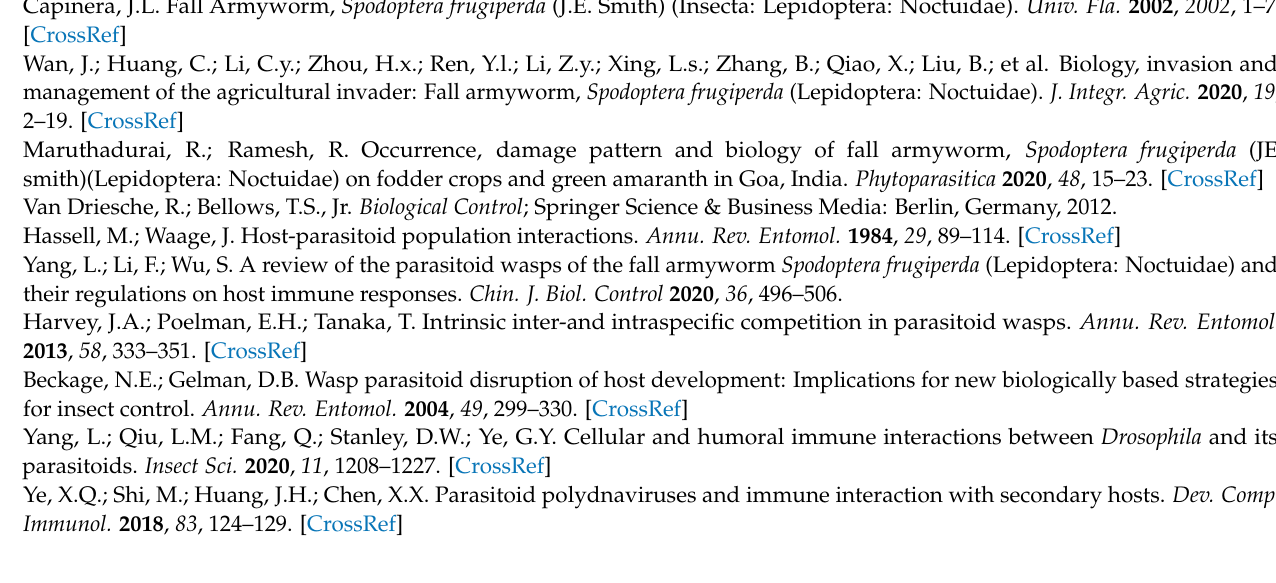
comparison; Table S4: The list of DEGs in P24 vs. NP24 comparison; Table S5: The list of DEGs in P48 vs. NP48 comparison; Table S6: The common DEGs involved in metabolism in at least two time points after parasitization; Table S7: The common DEGs involved in immunity in at least two time points after